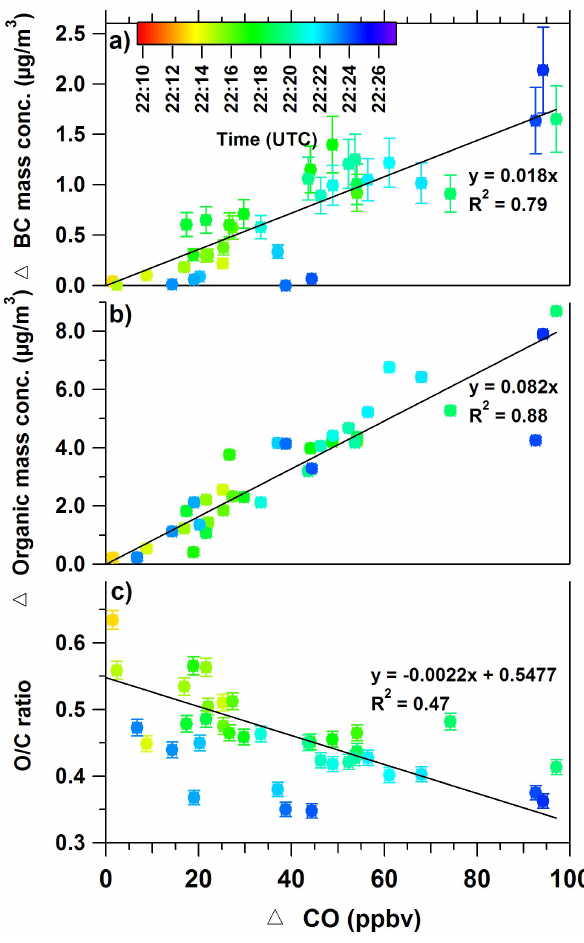
Fig. 6. Excess ( 1 ) (a) SP2 black carbon (BC) mass concentrations and (b) C-ToF-AMS organic mass concentrations versus 1 CO con- centrations as a function of RF03 plume sample time. (c) C-ToF- AMS organic O/C ratio versus 1 CO as a function of RF03 plume sample time. Note that CO data were not available over the entire RF03 smoke plume (see Fig.